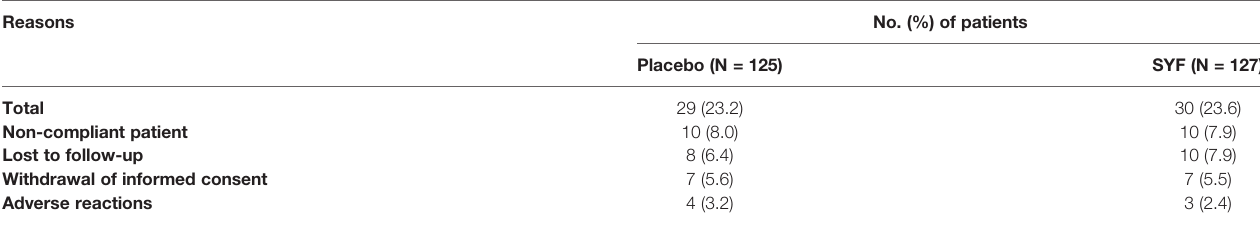
TABLE 2 | Summary of clinical trial termination.